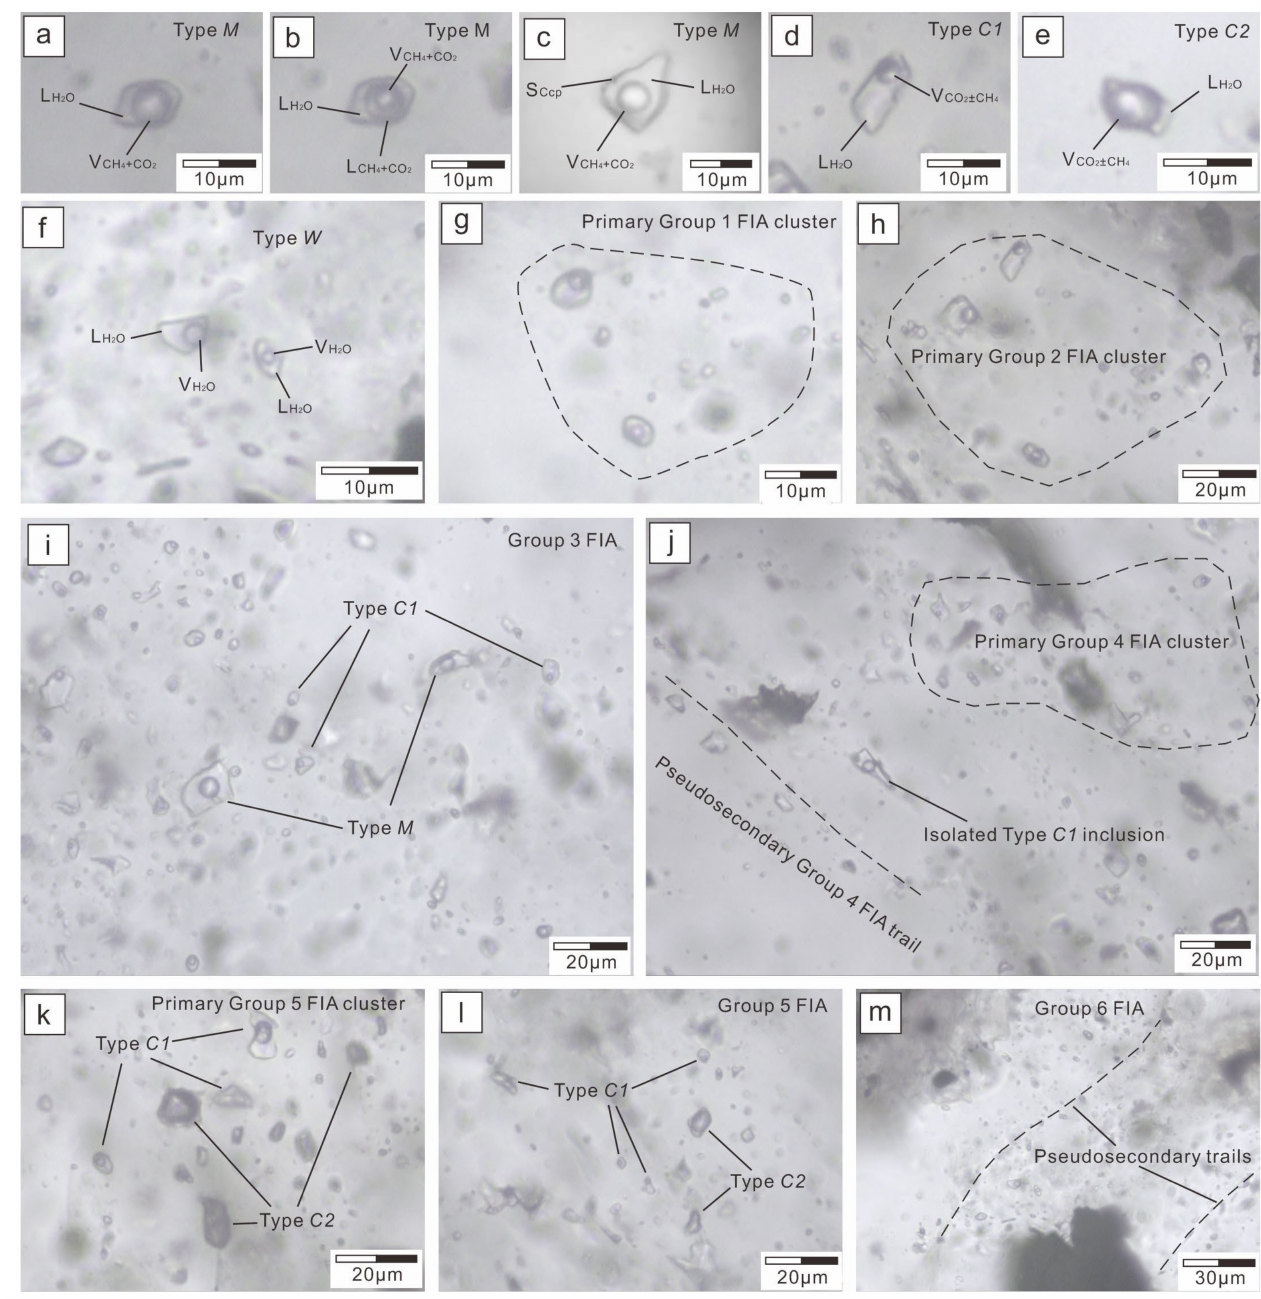
Figure 5. Photomicrographs of typical fluid inclusions and FIA groups in the Sanakham gold